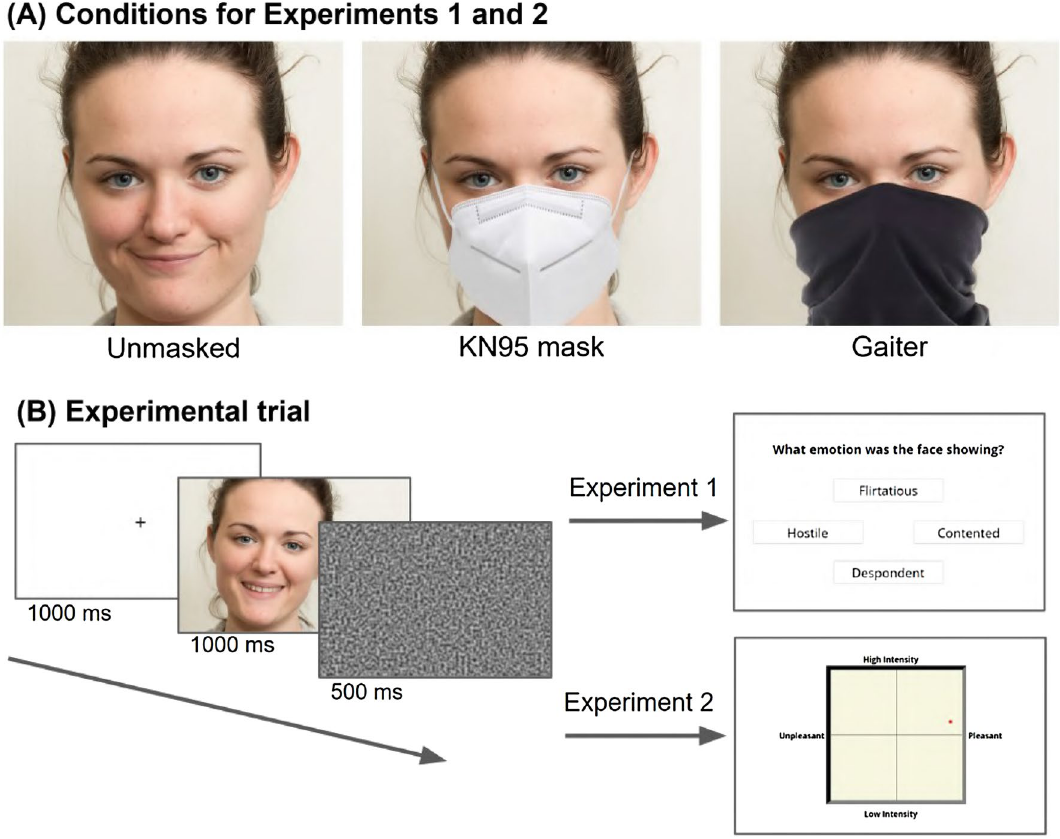
Figure 6. ( A ) Examples of the three conditions used in Experiments 1 and 2, which included 45 stimuli each. The KN95 mask and the neck gaiter were added to the images using Photoshop to make them look as natural as possible. Each condition was shown in a different experimental session, and each session was separated by at least a week from the previous one. ( B ) Experimental trial. For each stimulus in the condition, participants were presented with a fixation point, followed by the stimulus and then by random luminance noise. Subsequently, participants in Experiment 1 were asked to identify the mental state by selecting the correct label among four options. The three confound options presented with each stimulus were randomized, as was the spatial location in the diamond shape of each of the four labels. In Experiments 2 and 3, participants responded by clicking with their cursor in an affect grid, representing valence and arousal. There was no limit on response time in either experiment. Face images were obtained with permission from the public McGill Face Database 32 We used a more diverse set of stimuli for Experiment 3, which included pictures of both the white female actor and a white male actor taken from the McGill Face Database, as well as pictures of a black female actor and a latino male actor. The latter two were obtained from an ongoing facial expression project 55 which follows the methodology used in the McGill Face Database. The same 45 mental states as before were selected for each actor, making a total of 180 different expressions. This experiment made use of only two conditions: unmasked faces and KN95 masks (see Fig. 3A). To account for the idiosyncratic differences in facial expression, new classifications of the 45 mental states were carried out for each actor individually based on the average scores obtained in the